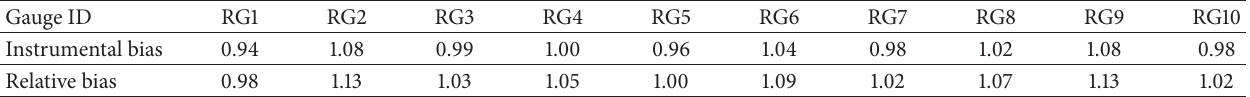
Table 4: The instrumental and relative biases of the 10 tipping bucket rain gauges.